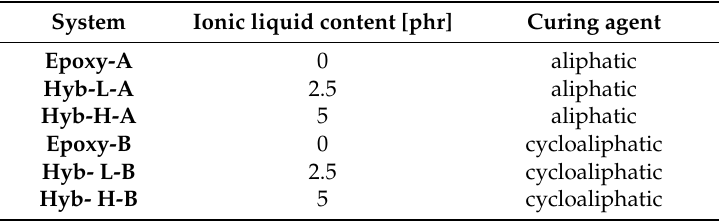
Table 1. Compositions of the studied